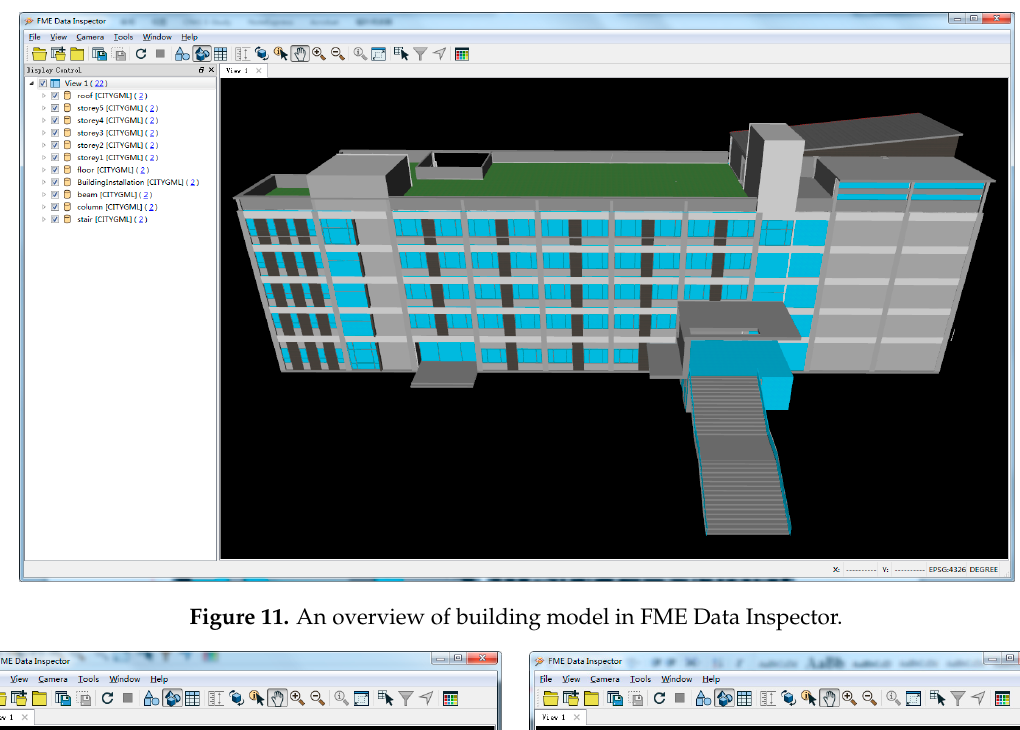
Figure 11. An overview of building model in FME Data Inspector.